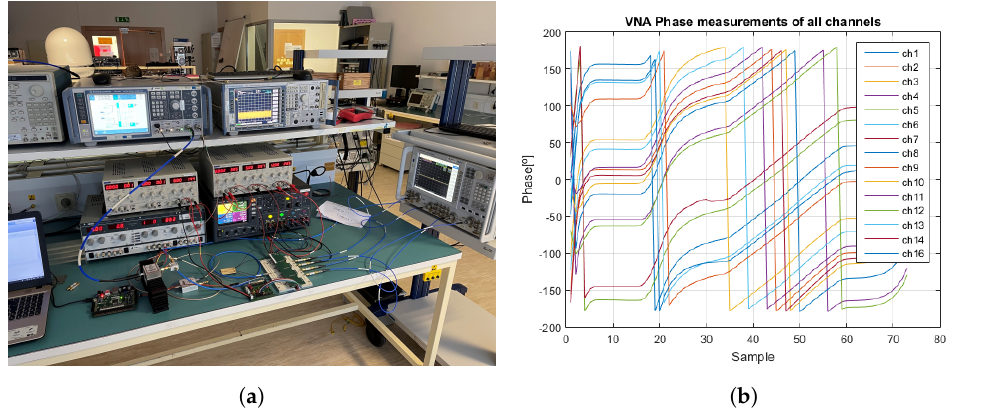
Figure 7. Measurement Setup to characterize the boards developed. ( a ) Validation and characteriza- tion setup using a VNA. ( b ) Phase differences of all 16 channels with different I and Q words.